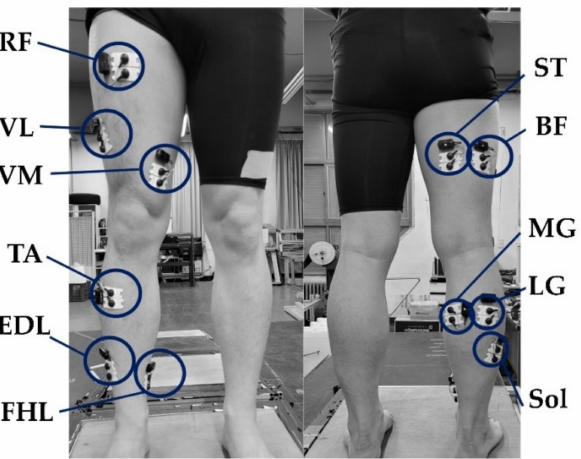
Figure 2. Attachment of electrodes. RF, VL, VM, ST, BF, MG, LG, Sol, TA, FHL, and EDL labels indicate the rectus femoris, vastus lateralis, vastus medialis, semitendinosus, biceps femoris, medial gastrocnemius, lateral gastrocnemius, soleus, tibialis anterior, flexor hallucis longus, and extensor digitorum longus,